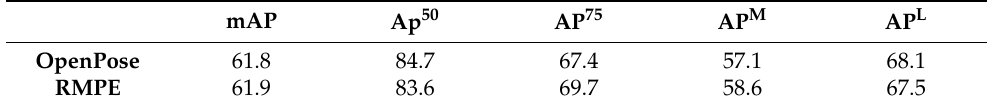
Table 2. MSC0C0 dataset experimental results.